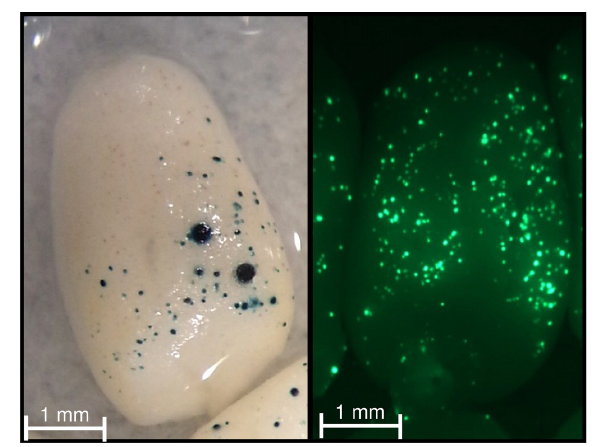
FIGURE 5 | GUS and GFP activities in wheat immature endosperm. Immature endosperm was co-bombarded with the pPrBx7-GUS and pAct-GFP constructs. Note the blue (bottom panel) and green (top panel) foci across the dorsal surface.